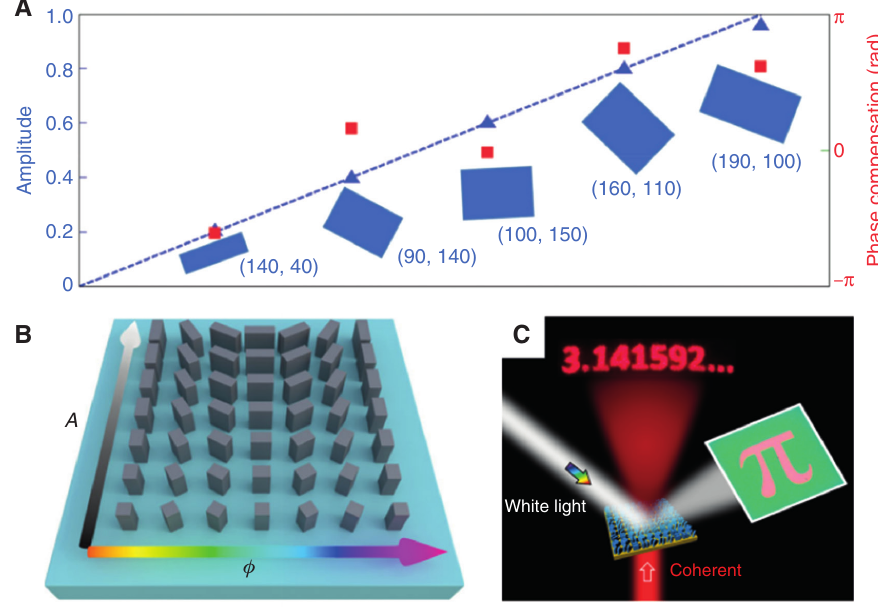
Figure 17: Metasurfaces with three design degrees of freedom for amplitude and phase manipulation. (A and B) Complex amplitude manipulation enabled with varied dimensions and orientations of nanostructures [129, 130]. (C) Concept of simultaneous nanoprintings and metaholography with spectral and phase manipulations [131]. Reprint permission obtained from